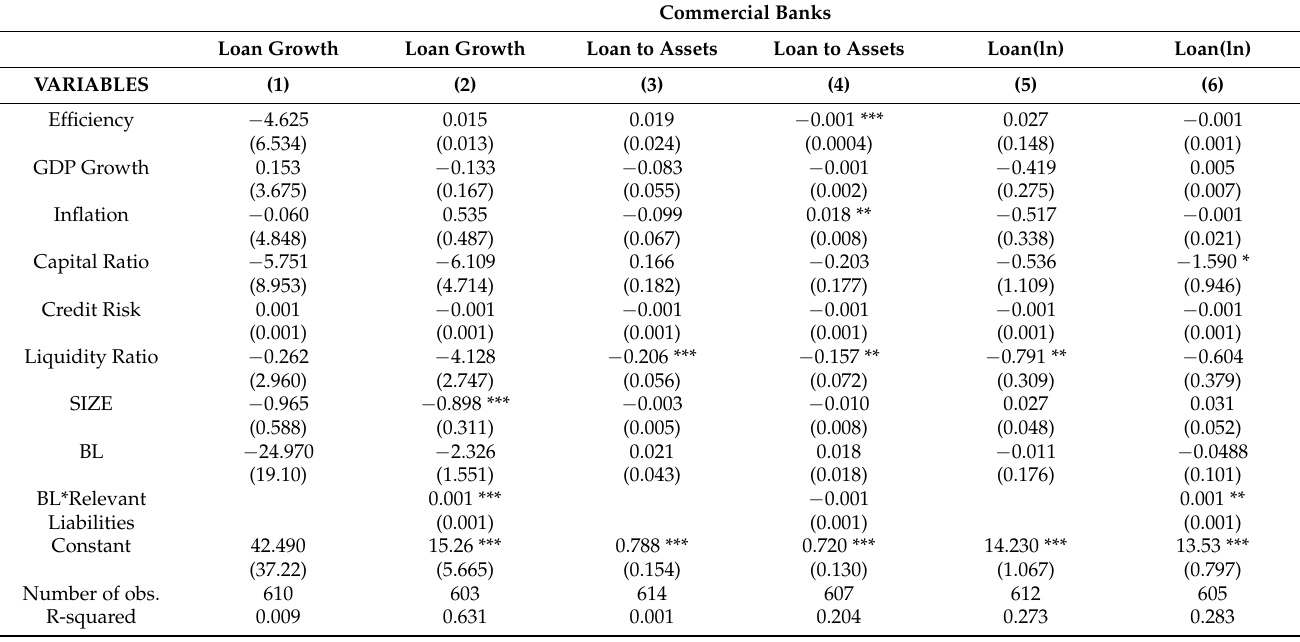
Table A5. Data presenting estimates based on GLS regressions with a random effect on all German commercial banks. Symbols *, **, and *** represent statistical significance at the levels of 10%, 5%, and 1%,